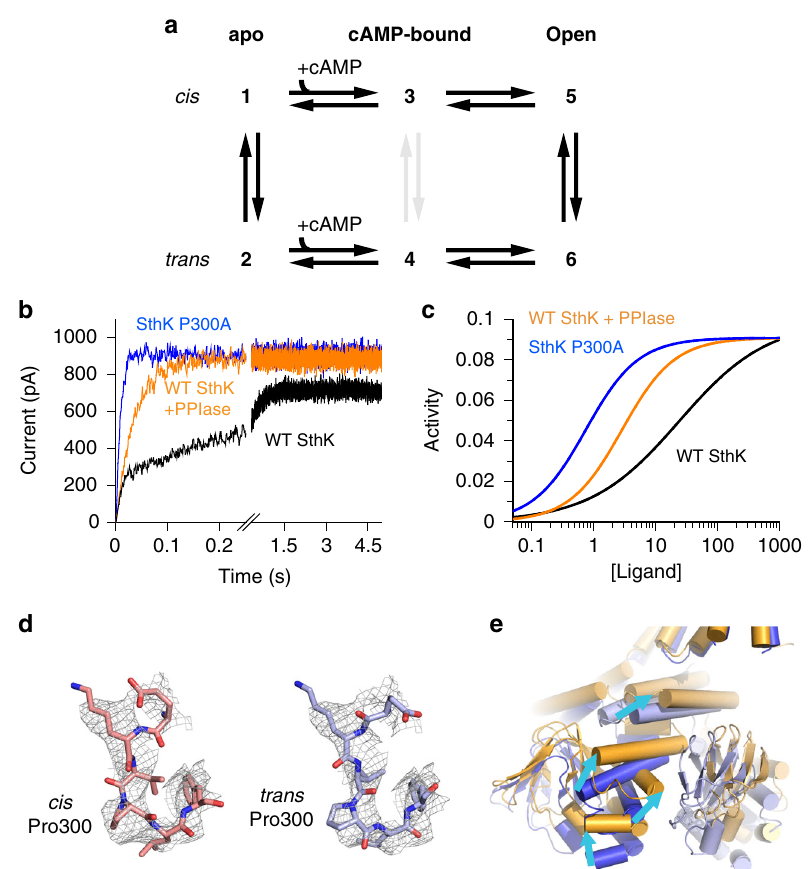
Fig. 5 Mechanistic and structural implications of the proline switch in SthK. a Model of the modulatory prolyl isomerization in SthK used for simulations as shown in ( b , c ), and Supplementary Fig. 9f – i. Transitions in gray were omitted for the simulations since their inclusion does not change the outcome and to reduce the number of parameters. b Simulated, macroscopic activation time courses of 10,000 channels upon ligand application (100 µ M cAMP) according to the model shown in ( a ). c Comparison of the theoretical dose-response curves of WT SthK (black), WT SthK + PPIase (orange), and SthK P300A (blue) after 2.5 s activation by cAMP (same condition as the experimental stopped- fl ow assay shown in Fig. 3d). Conditions and results of simulations are given in Supplementary Table 3 and 4. d Modeled cis Pro300 (left panel) in comparison to trans Pro300 (right panel) in WT SthK (PDB: 6CJU, EMDB: 7484). e Propagation of conformational changes during gating of SthK through one CNBD and along the subunit interface. The closed state of SthK P300A is shown in blue, the putatively active state in